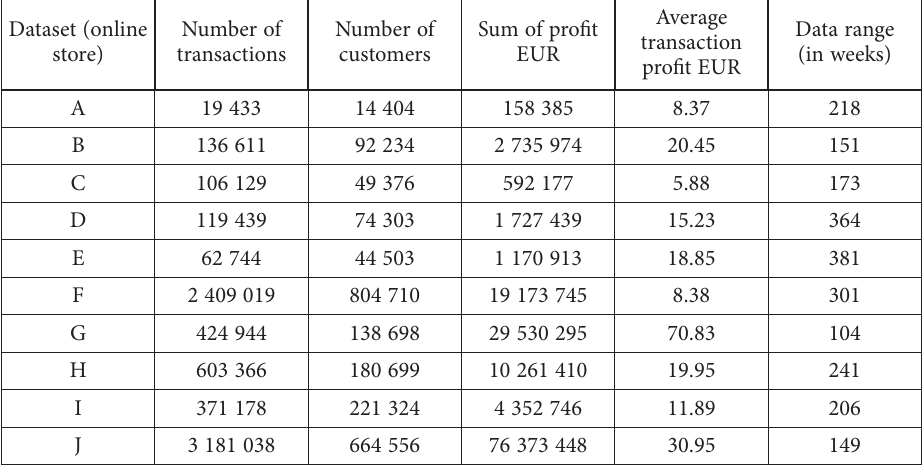
Table 2. Summary information about individual online stores and available data Dataset (online